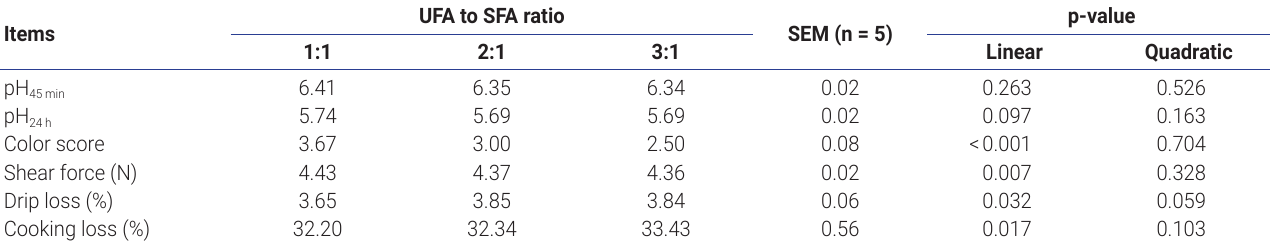
UFA to SFA ratio